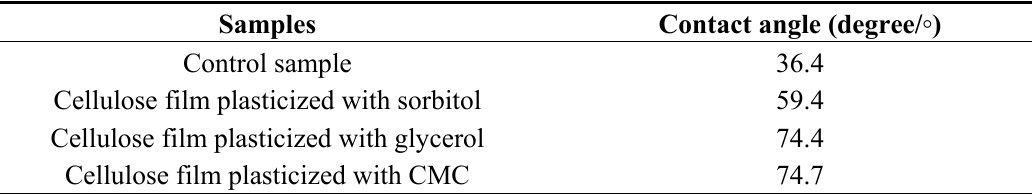
Table 1. Water contact angle values of cellulose